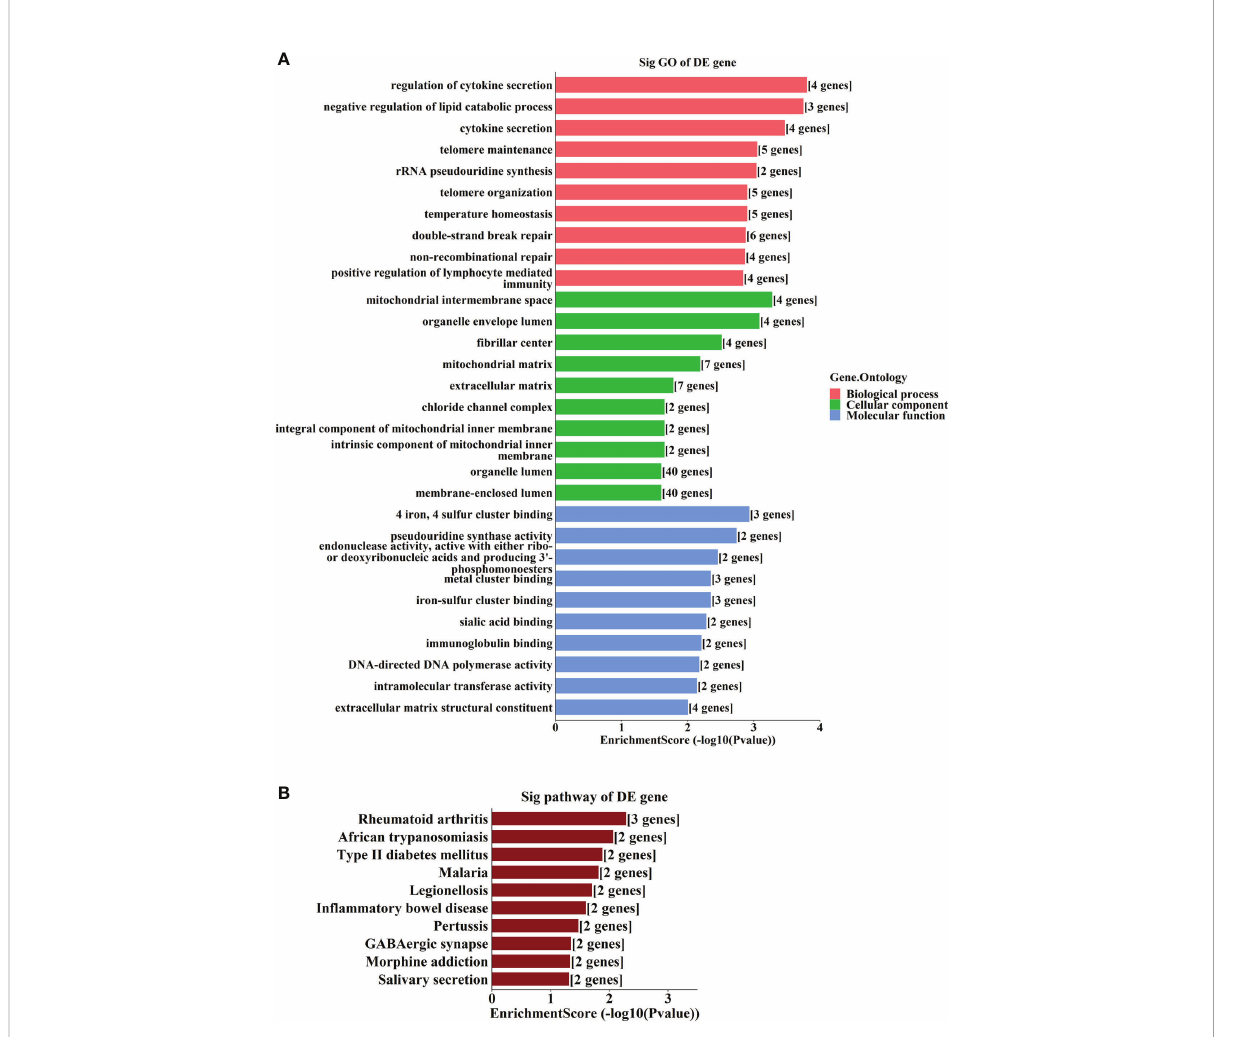
FIGURE 6 GO and KEGG analyses according to the target genes in ceRNA network. (A) Top gene ontology (GO) terms with the target genes in the competing endogenous RNA (ceRNA) network. (B) Top Kyoto Encyclopedia of Genes and Genomes (KEGG) pathways with the target genes in ceRNA